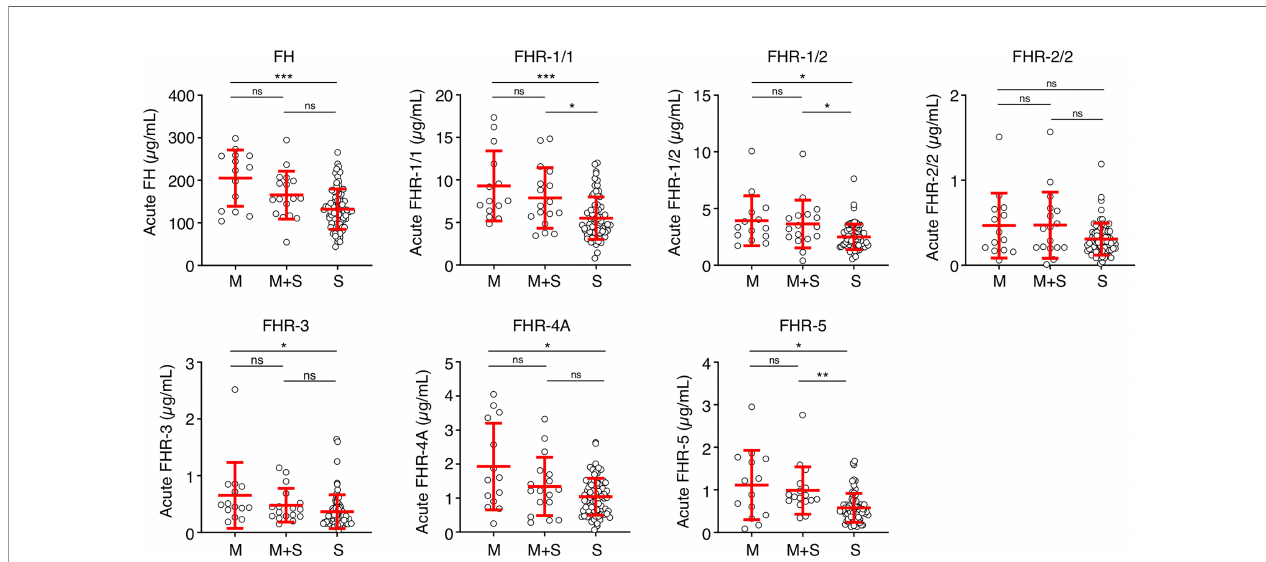
FIGURE 3 | FH family proteins per clinical syndrome. Protein levels of FH, FHR-1/1, FHR-1/2, FHR-3, FHR-4A and FHR-5 at the acute stage ( fi rst sample obtained during hospitalization, n = 106), according to the diagnosed clinical syndrome: meningococcal meningitis (M, n = 14), meningococcal septicemia (S, n = 75), or both (M+S, n = 17). Statistical signi fi cance was tested using a Kruskal-Wallis test, followed by a Dunn ’ s multiple comparisons test. Lines depict median and IQR. ** p < 0.01; * p < 0.05; ***p < 0.001; ns, not signi fi cant.